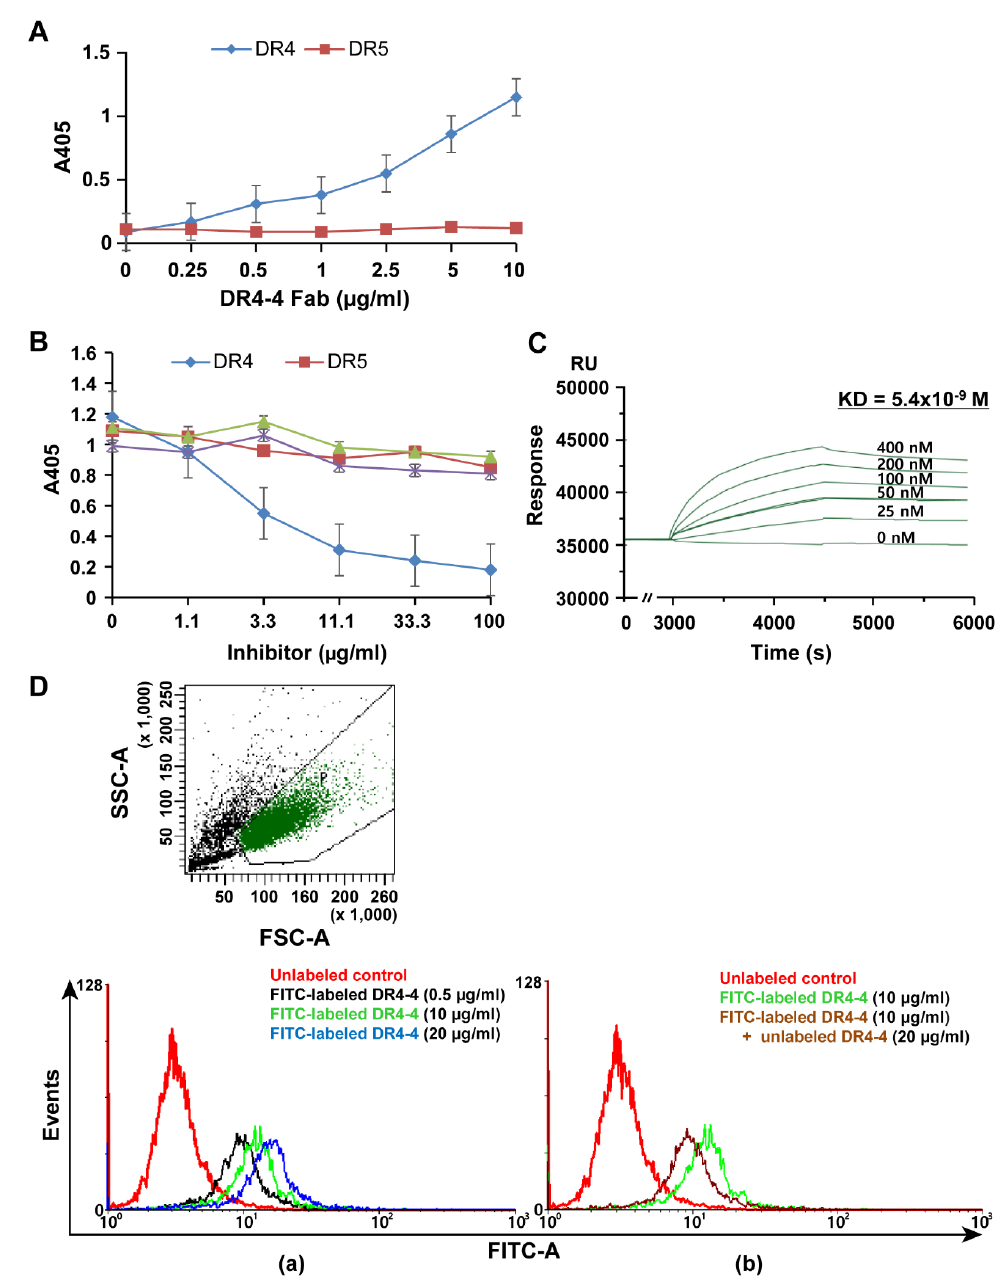
Figure 2. Specific binding of DR4-4 Fab to DR4 antigen. Direct-binding ( A ) and competitive ( B ) enzyme-linked immunosorbent assay (ELISA) for specific binding of DR4-4 Fab to DR4. Recombinant DR4 and DR5 were coated onto the wells of ELISA plates at 5 µg/mL, followed by incubation with DR4-4 Fab ( A ) or DR4-4 Fab preincubated with competitor, DR4 or DR5 ( B ) (data presented as mean ± standard deviation). ( C ) Binding affinity of recombinant human DR4 antigen for DR4-4 (1 µM) immobilized on a nitrile triacetic acid chip as measured by Biacore surface plasmon resonance. ( D ) Fluorescence-activated cell sorting analysis of the cellular binding of DR4-4 Fab. Cells (5 × 10 5 ) were incubated with fluorescein isothiocyanate (FITC)-labeled DR4-4 Fab for 30 min at 4 °C without ( a ) or with ( b ) pretreatment with unlabeled DR4-4 Fab. Dot plot presents the profile of forward scatter (FSC)/side scatter (SSC) of control cells. P is a gate of cells which were used for the analysis. ( C , D ) are representative results among triplicate experiments.